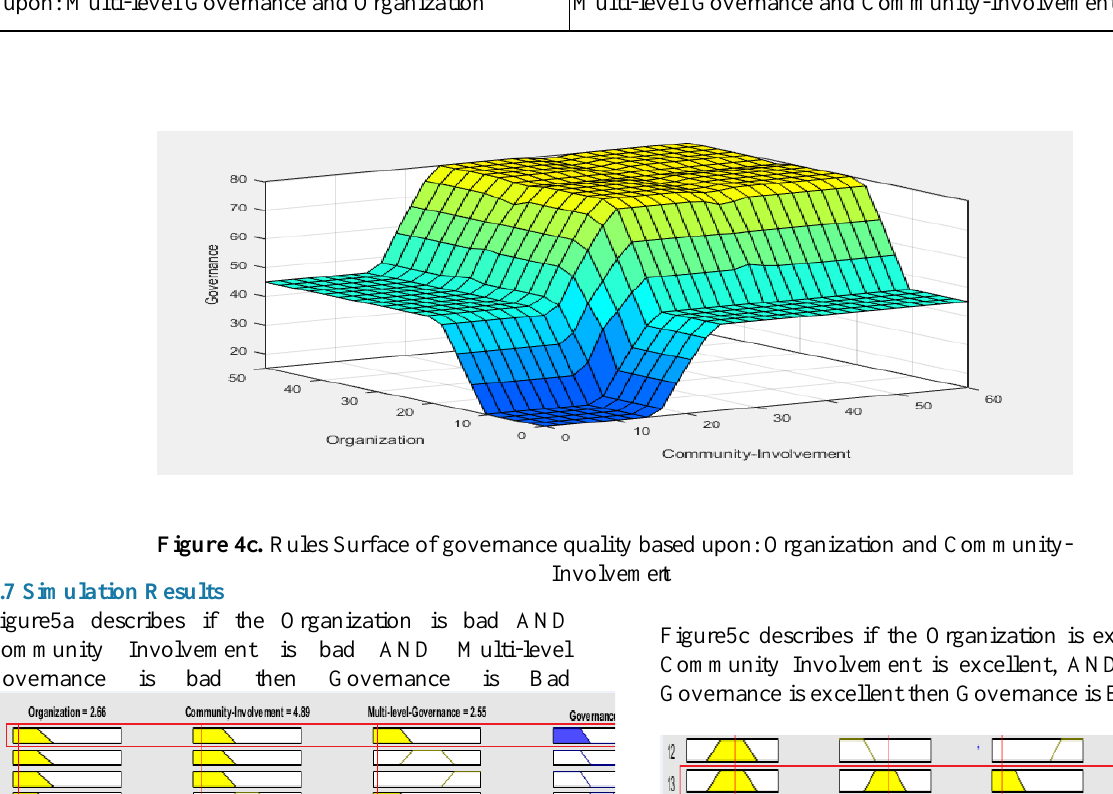
Figure 4a . Rules Surface of governance quality based upon: Multi-level Governance and Organization